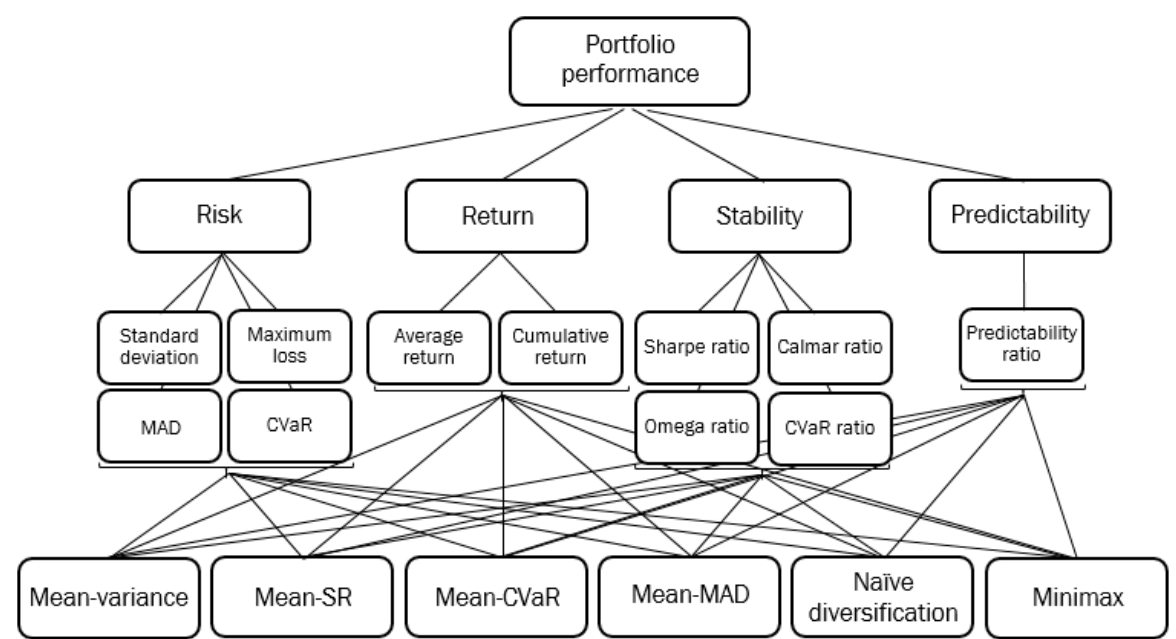
Figure 1. Hierarchical decision tree.